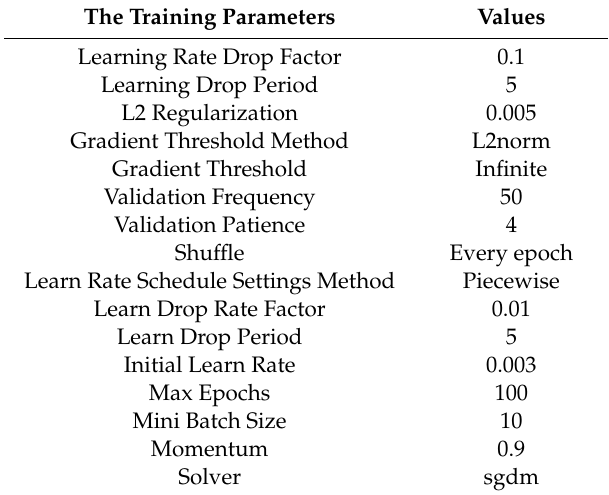
Table 1. Training Table 1. Training parameters.